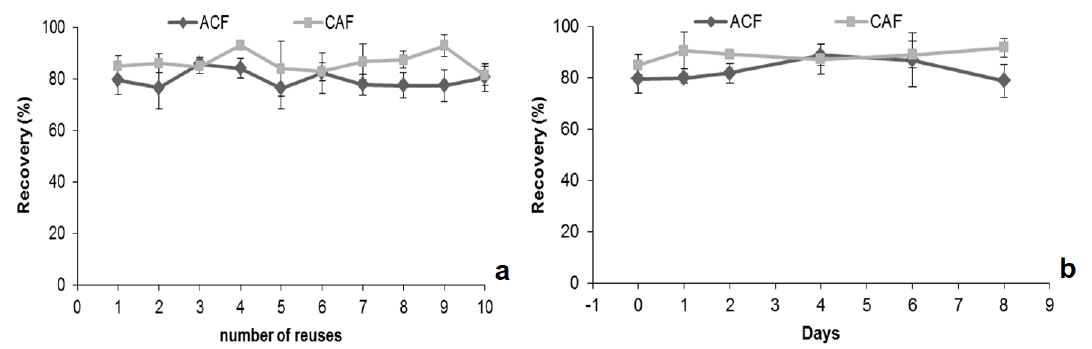
Figure 5. Comparison of recoveries of ACF and CAF after several reuses ( a ) and influence of storage time ( b ).